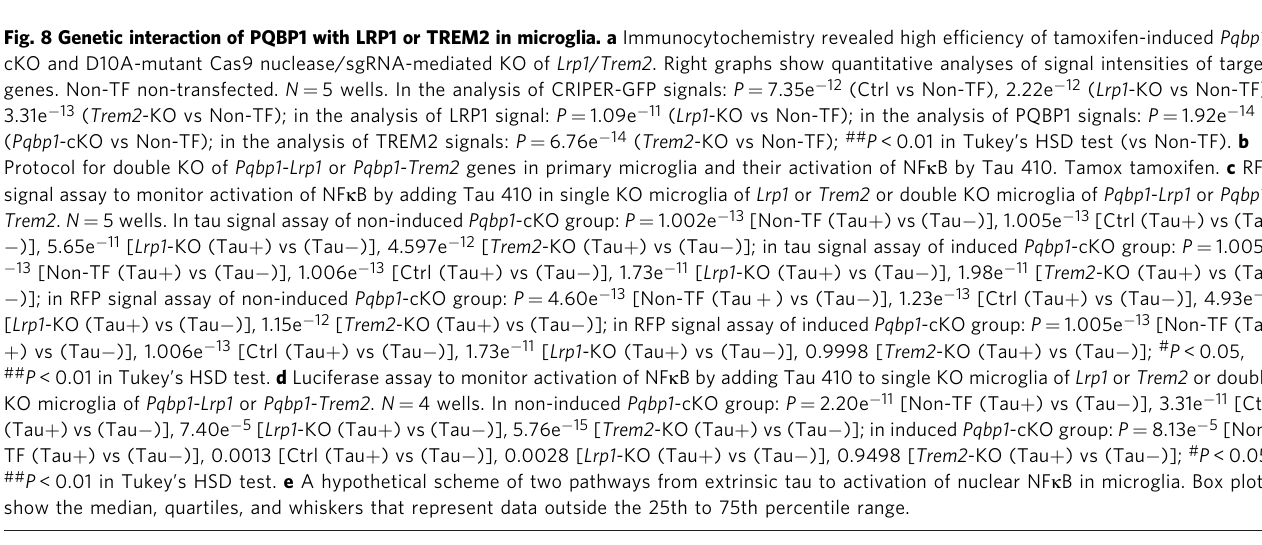
Fig. 8 Genetic interaction of PQBP1 with LRP1 or TREM2 in microglia. a Immunocytochemistry revealed high ef fi ciency of tamoxifen-induced Pqbp1 - cKO and D10A-mutant Cas9 nuclease/sgRNA-mediated KO of Lrp1 / Trem2 . Right graphs show quantitative analyses of signal intensities of target genes. Non-TF non-transfected. N = 5 wells. In the analysis of CRIPER-GFP signals: P = 7.35e − 12 (Ctrl vs Non-TF), 2.22e − 12 ( Lrp1 -KO vs